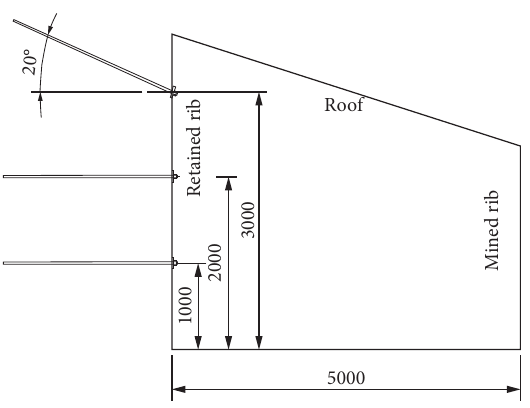
Figure 8: Grouting bolts layout.